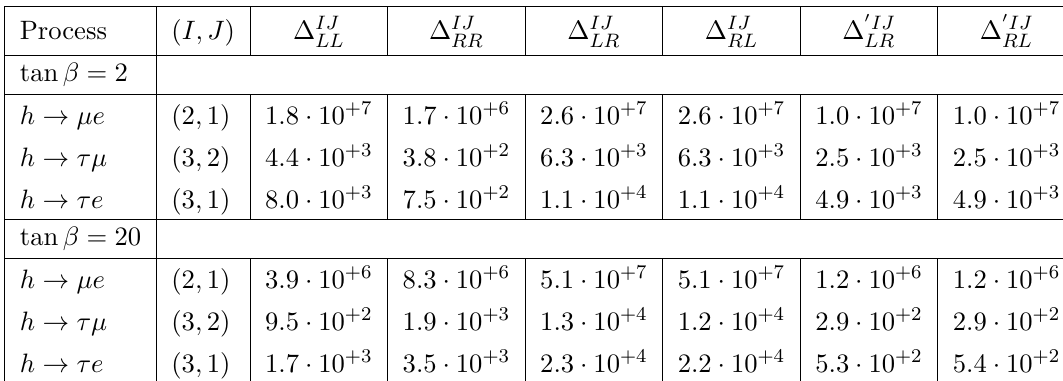
, (cid:1) IJ , (cid:1) 0 IJ LL RR LR